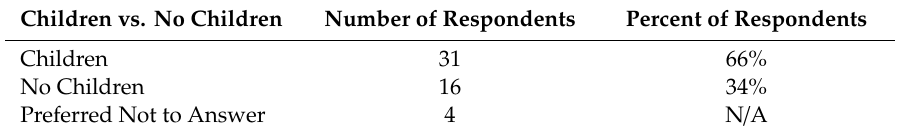
Table A5. Frequency of participants having